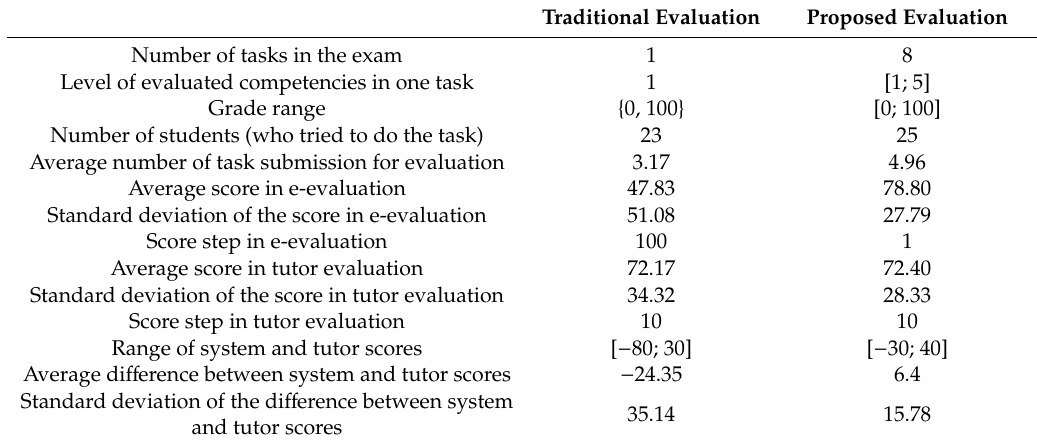
Table 1. Student evaluation results by using the traditional and proposed